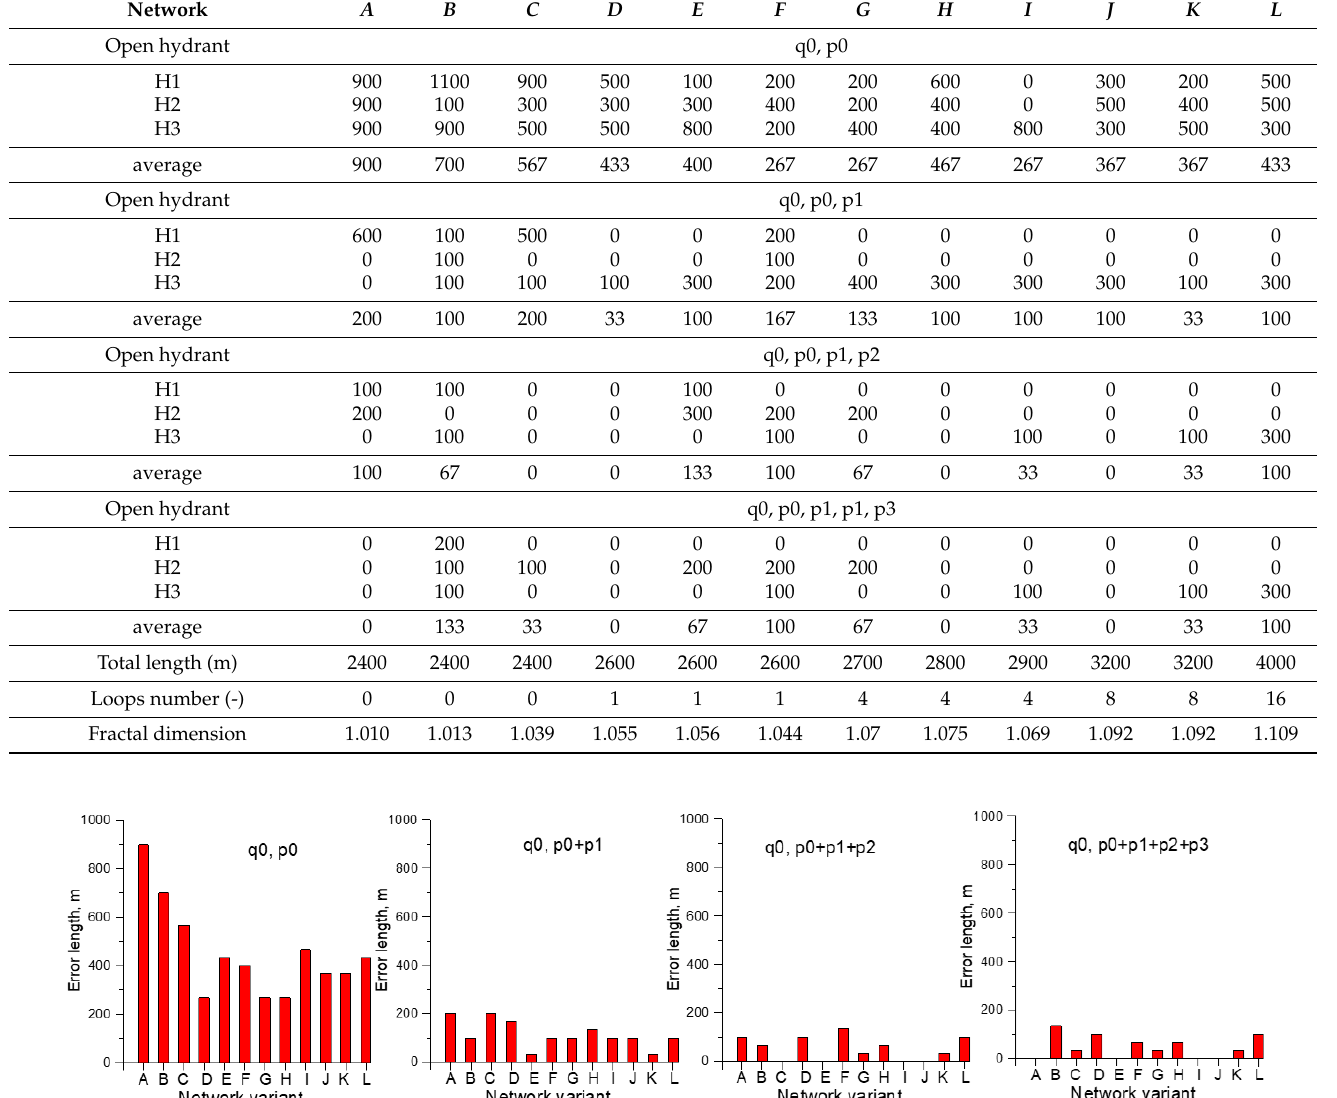
Figure 11. The average length of the error in relation to the total pipe length and the number of monitoring sensors applied.